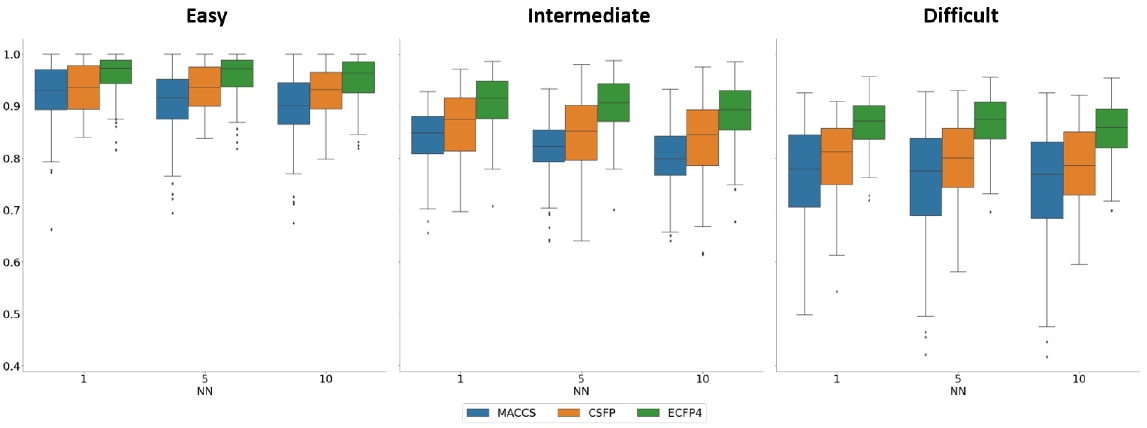
Figure 5. Similarity searching. Boxplots report the mean AUC ROC values for 1-, 5-, and 10-NN similarity searching with 10 reference compounds across all activity classes.